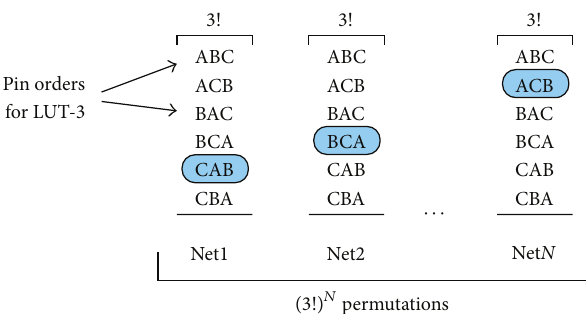
Figure 14: Possible permutations for 𝑁 netlists using LUT-3.